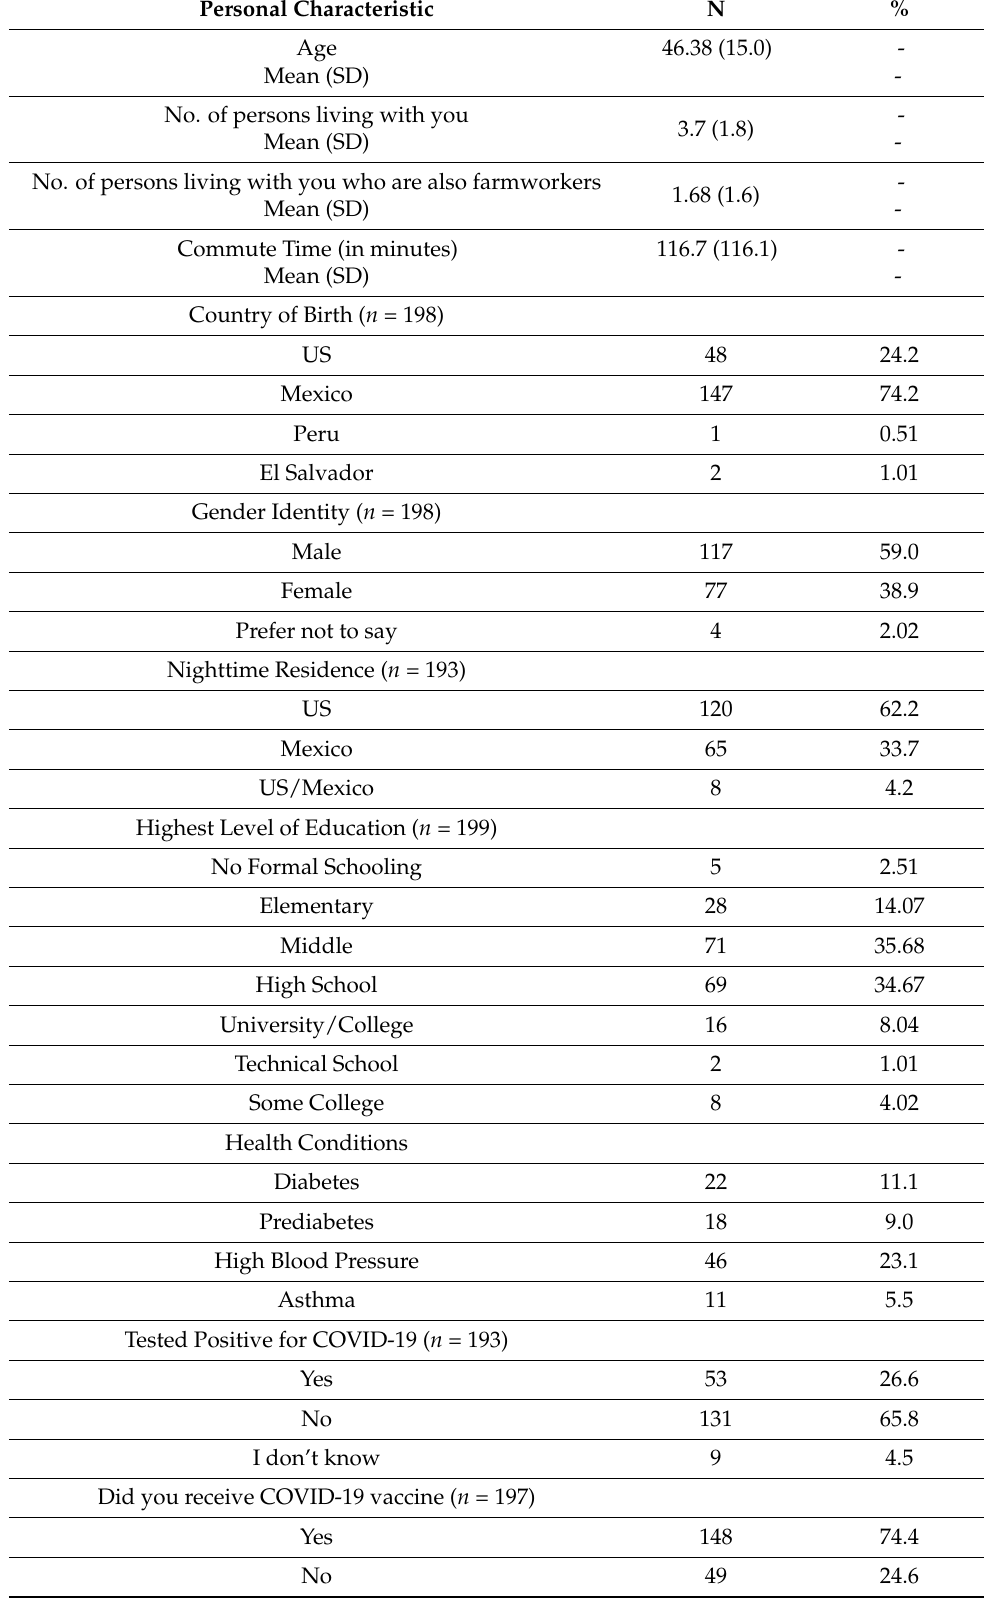
Table 1. Personal characteristics of Hispanic/Latino farmworker study participants ( n =